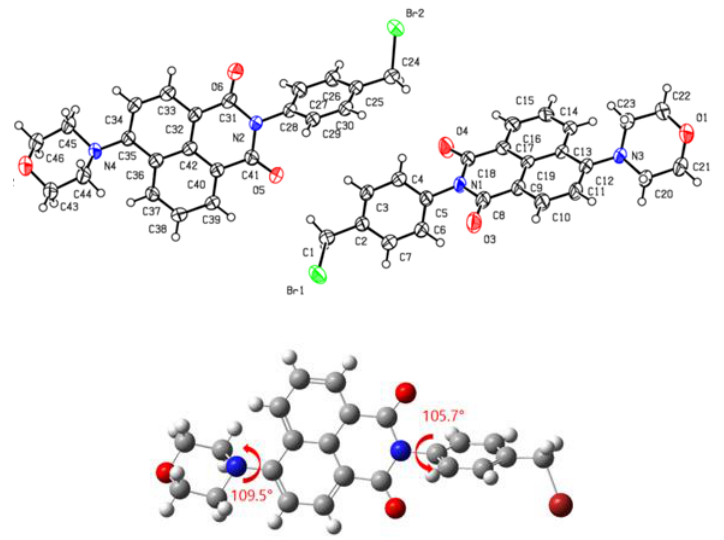
Figure 1. X-ray crystal structure of 3O .